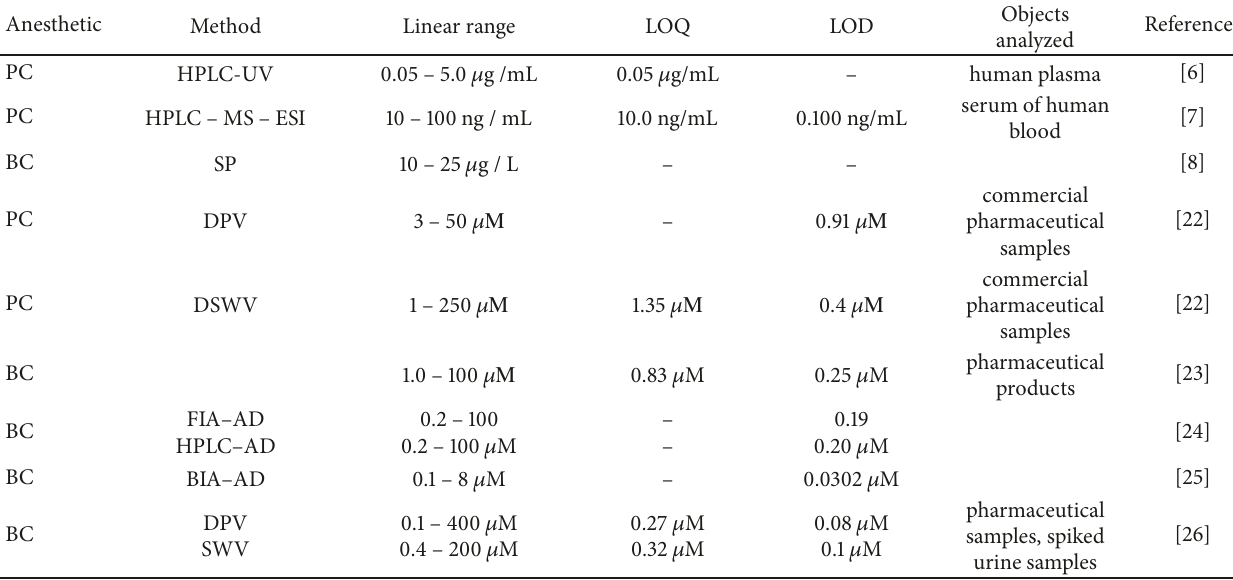
Table 1: Brief description of some methods for determination of BC and